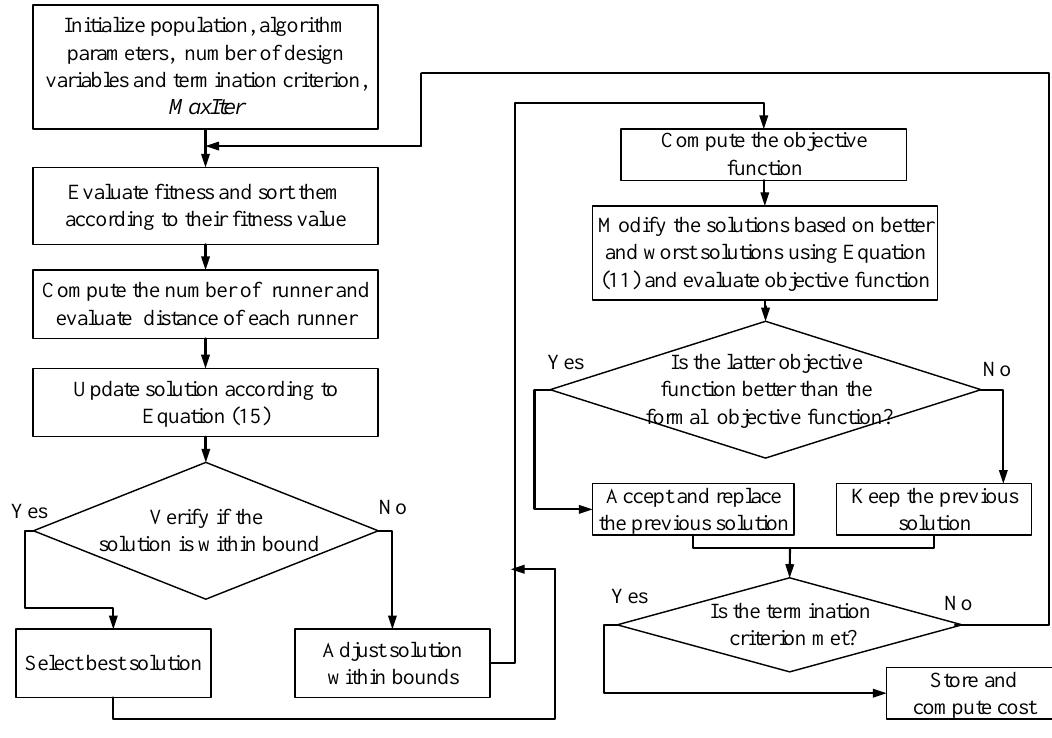
Figure 4. Proposed Earliglow